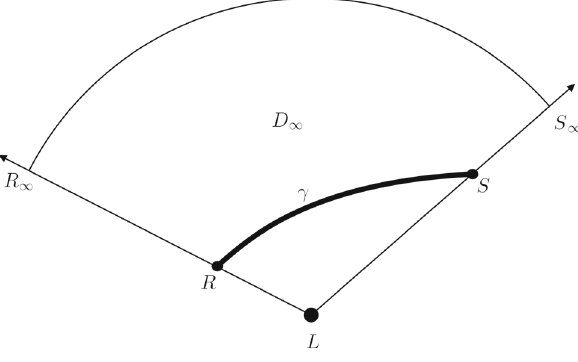
Fig. 2 Sketch of the region D ∞ = R ∞